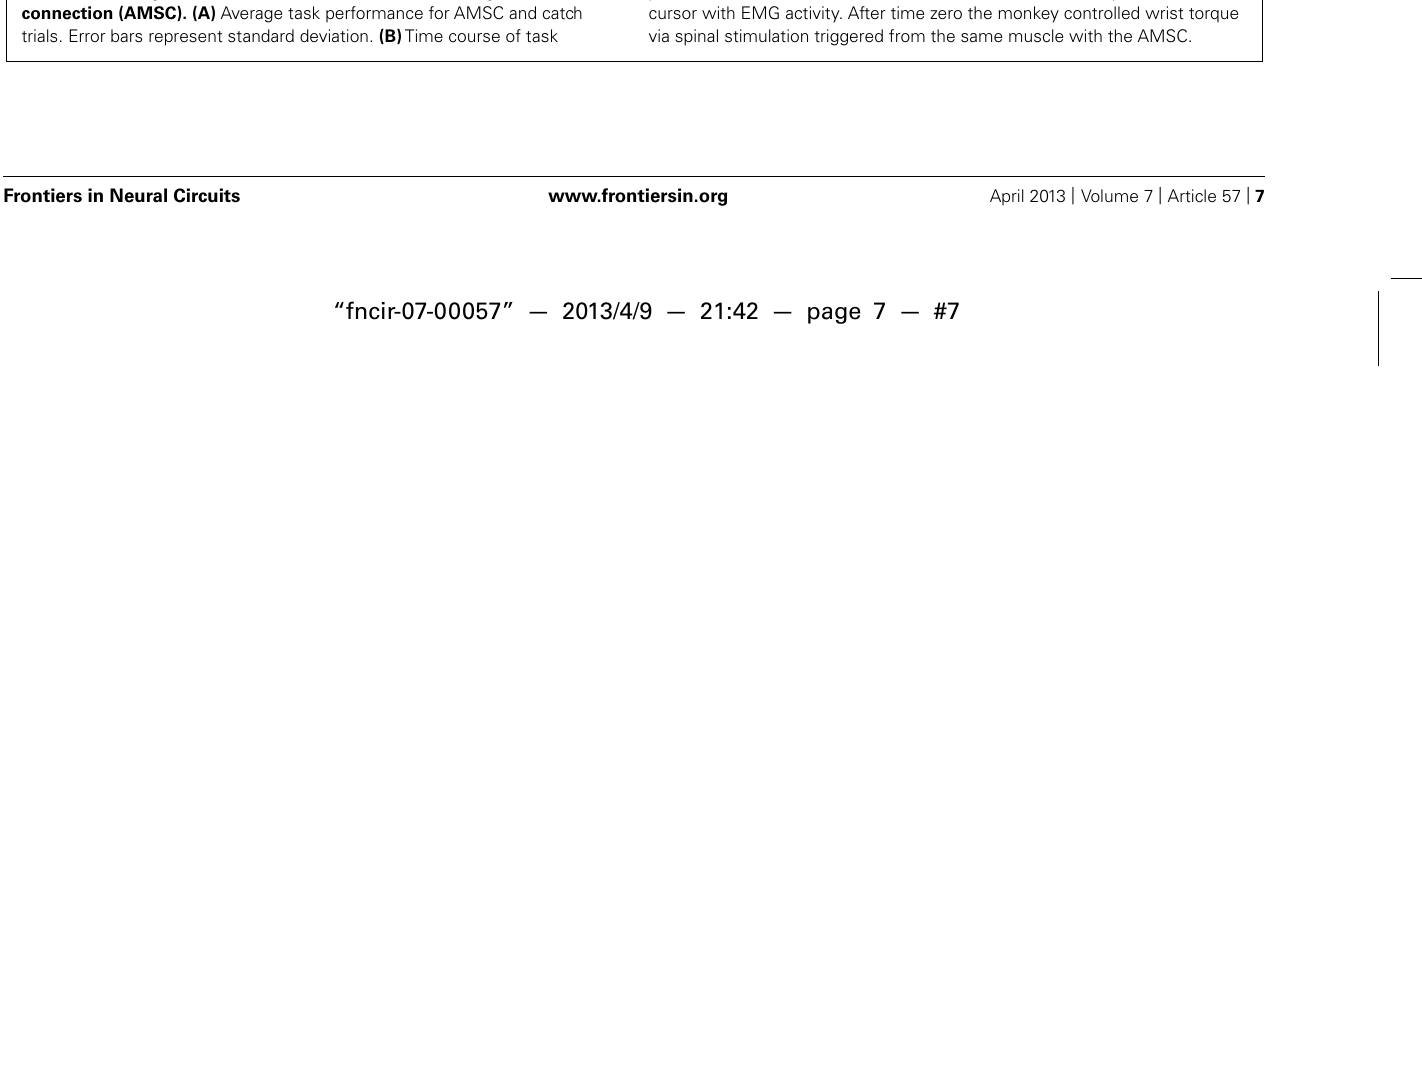
performance in AMSC session. Before time zero the monkey controlled the cursor with EMG activity. After time zero the monkey controlled wrist torque via spinal stimulation triggered from the same muscle with the